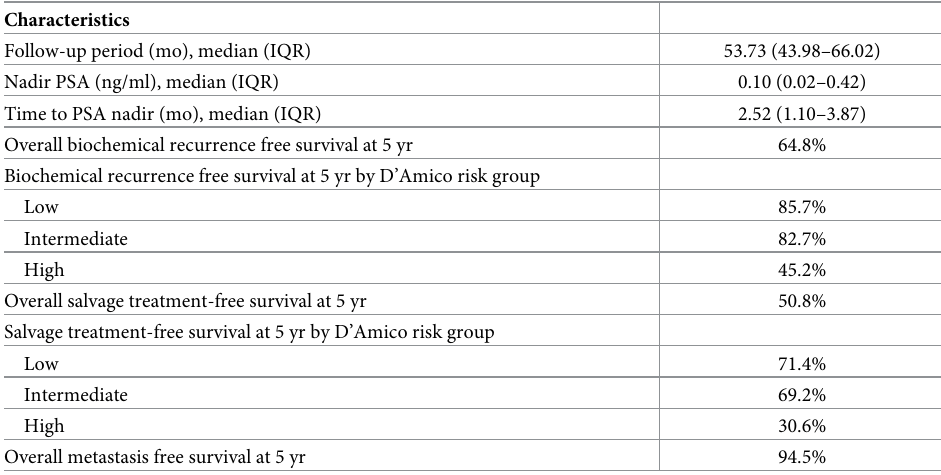
Table 2. Oncological